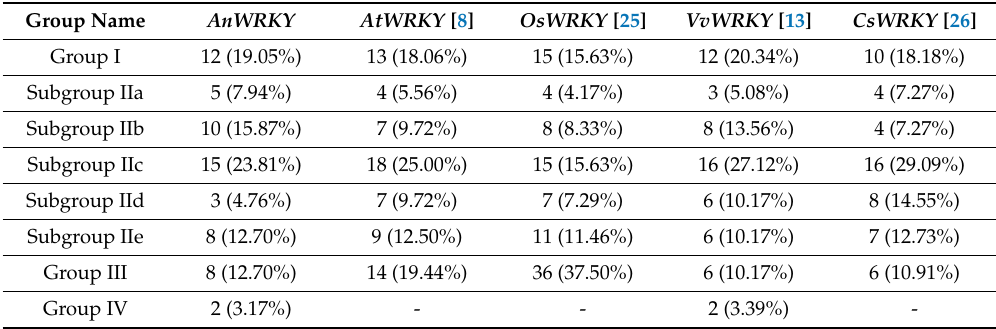
Table 3. The number and proportion of WRKY genes in A. nanus (An), Arabidopsis (At), rice (Os), grapevine (Vv), and cucumber